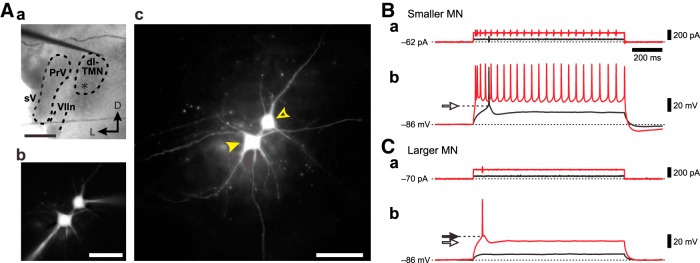
Membrane potential responses to depolarizing current pulses in smaller and larger MNs in the dl-TMN. Aa, A brainstem slice including the dl-TMN. A stimulation electrode was placed just dorsal to the TMN. PrV, Trigeminal principle nucleus; VIIn, facial nerve; sV, sensory root of the trigeminal nerve. Scale bar, 500 μm. Ab, A simultaneous recording obtained from a pair of smaller and larger MNs that were filled with Lucifer yellow. Scale bar, 100 μm. Ac, A Lucifer yellow image of the smaller and larger MNs after fixation with paraformaldehyde (open and filled arrowheads, respectively). Scale bar, 100 μm. B, C, Membrane potential responses to depolarizing current pulses applied to the smaller and larger MNs (Bb and Cb, respectively) from the same baseline membrane potential of −86 mV brought about by negative DC current injection of −62 and −70 pA, respectively (Ba and Ca, respectively). The apparent spike threshold was lower in the smaller MN (open arrow) than in the larger MN (filled arrow).